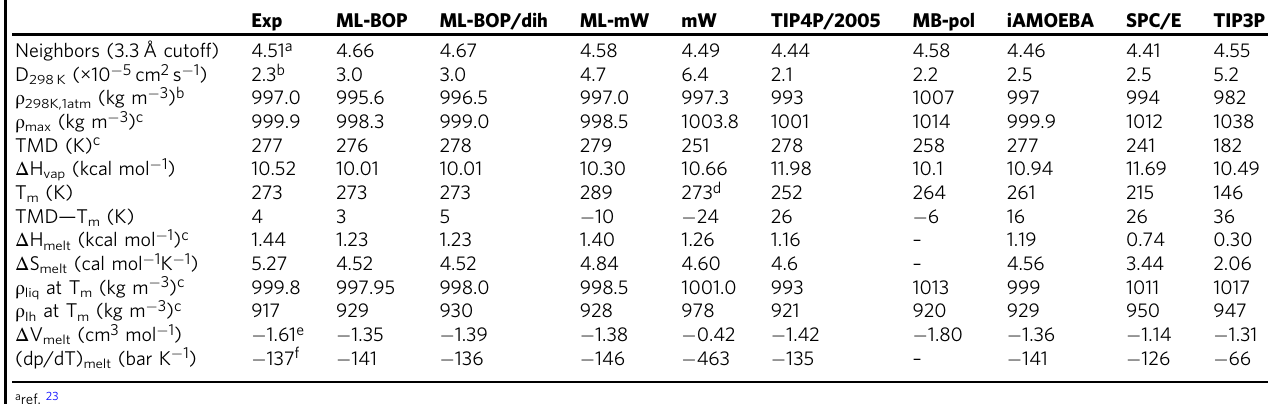
dashed and dotted cross marks in Fig. 3b mark the interatomic angles (~37°, ~72°, ~155°) at which the dashed and dotted energy curves in (a) are evaluated. The overall effect of bond order in the